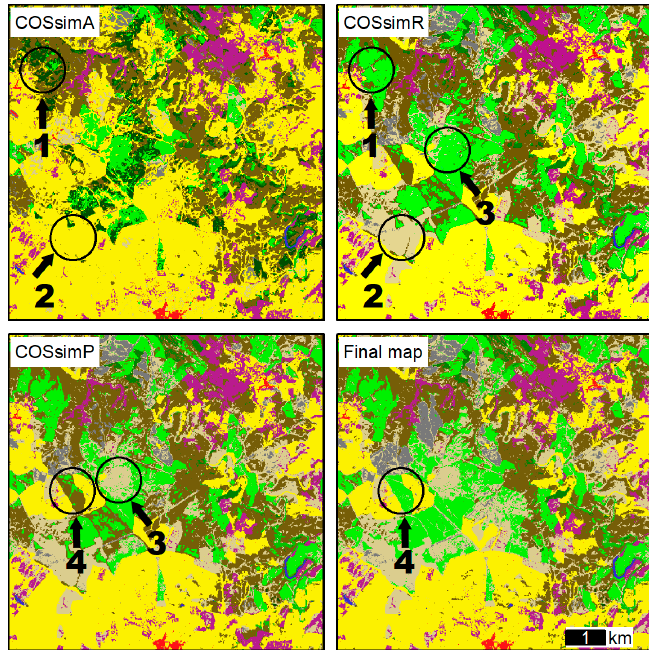
Figure 8. Progress of mapping in a region of southern Portugal. Zone 1 in COSsimR corrects confusions between shrubland, conifers, and broadleaves, and zone 2 highlights natural grassland previously misclassified as agriculture. Zone 3 in COSsimP maps a clear-cut of eucalyptus that occurred during 2018, and zone 4 points to eucalyptus identified manually after being misclassified as natural grassland and shrub in previous stages. Zones 1 to 4 are flagged with a circle in the maps before and after improvement.